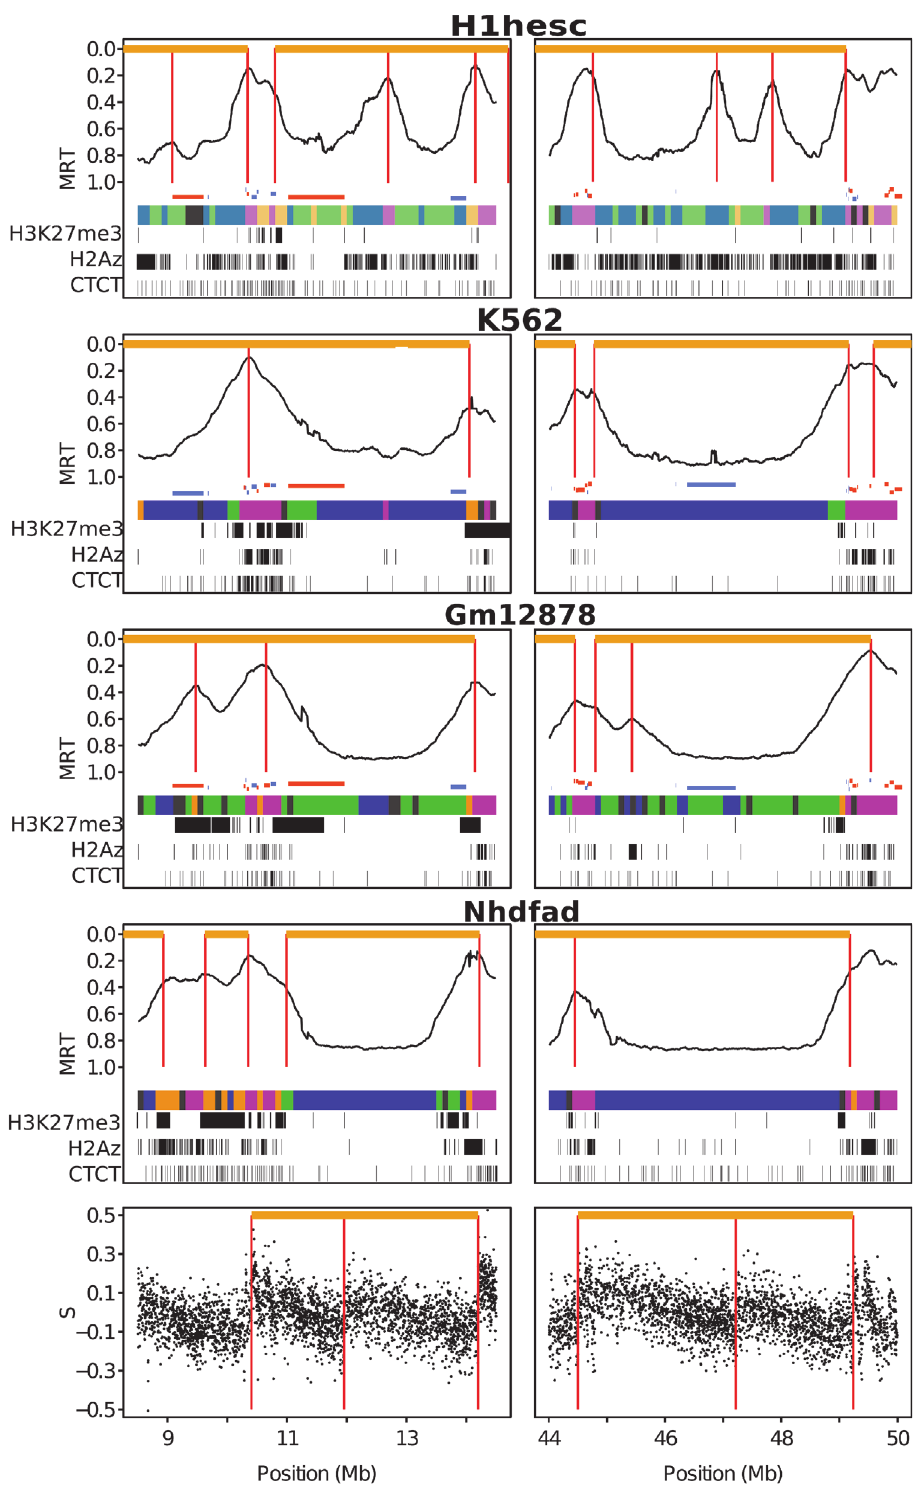
Figure 5. Genome-wide spatial distribution of chromatin states in ESCs and differentiated cells. MRT profile along two Mb long fragments of human chromosome 5 (left) and 14 (right). U-domains are marked by an horizontal orange line and their borders by vertical red lines. Below the MRT profile, gene positions are indicated by a horizontal segment (blue: not expressed, orange: expressed) as well as the chromatin state